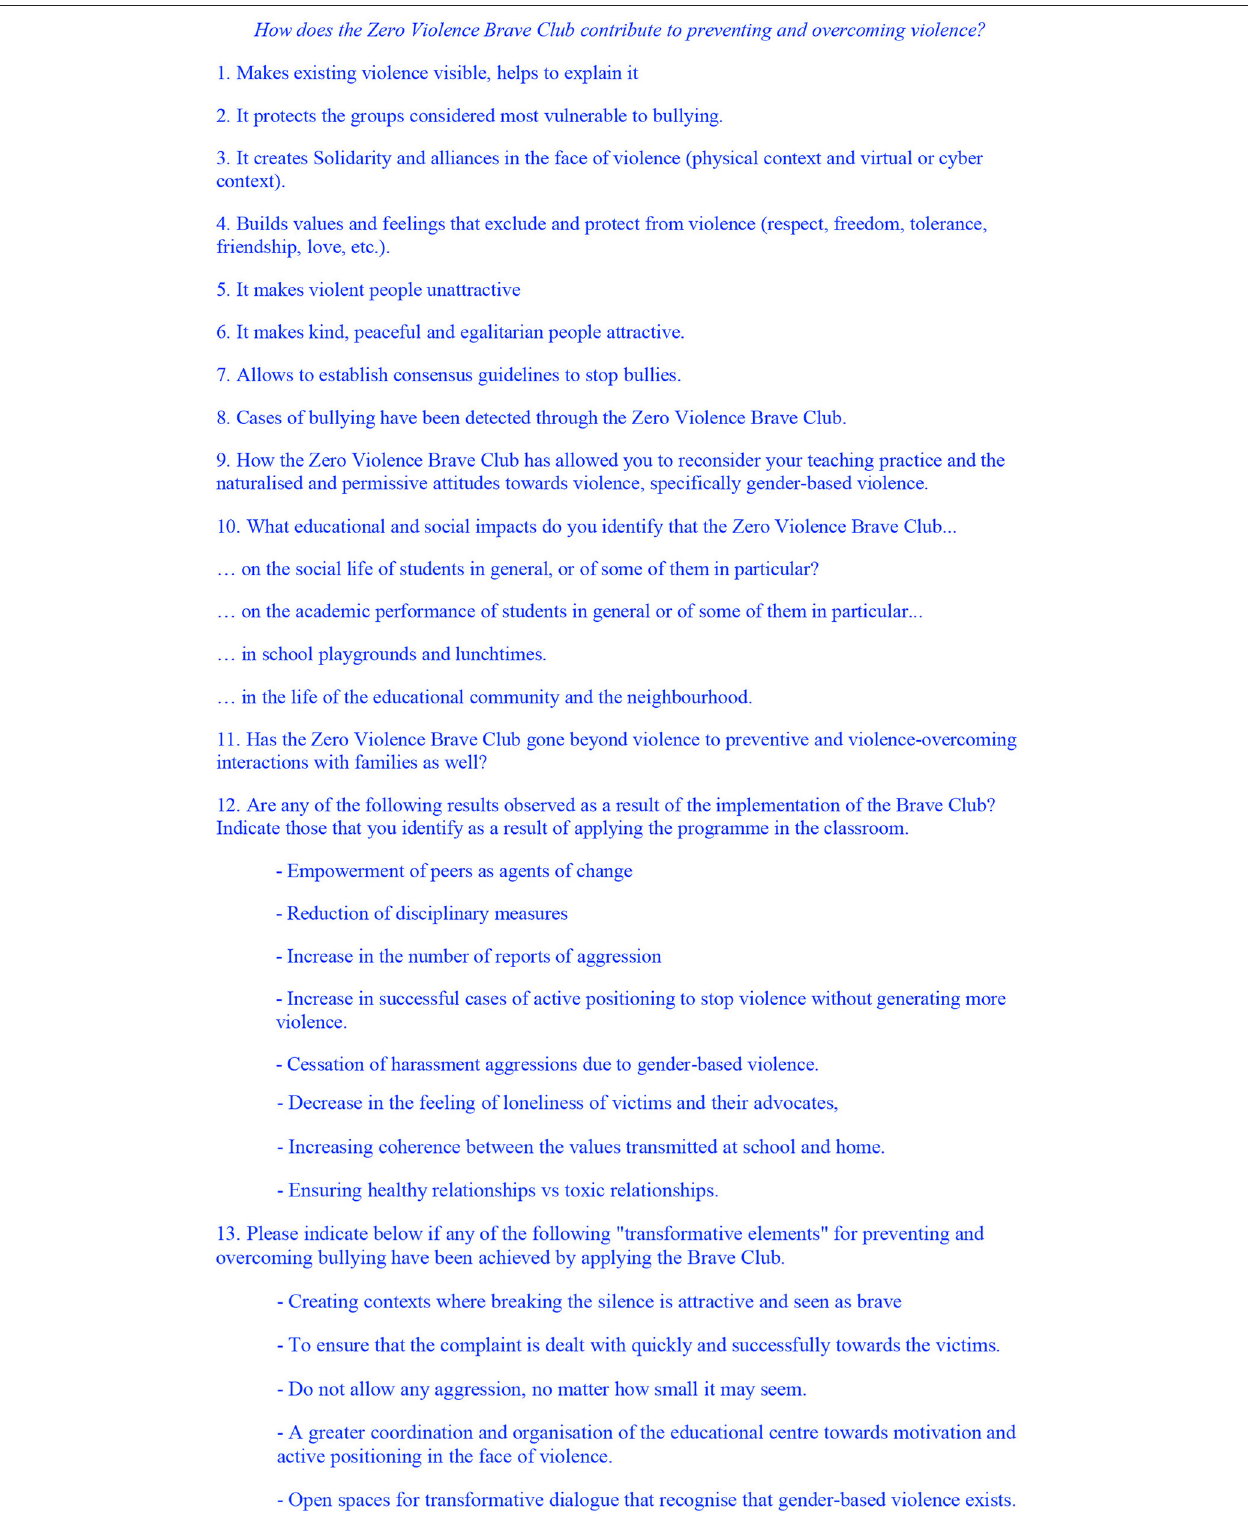
Frontiers in Psychiatry |